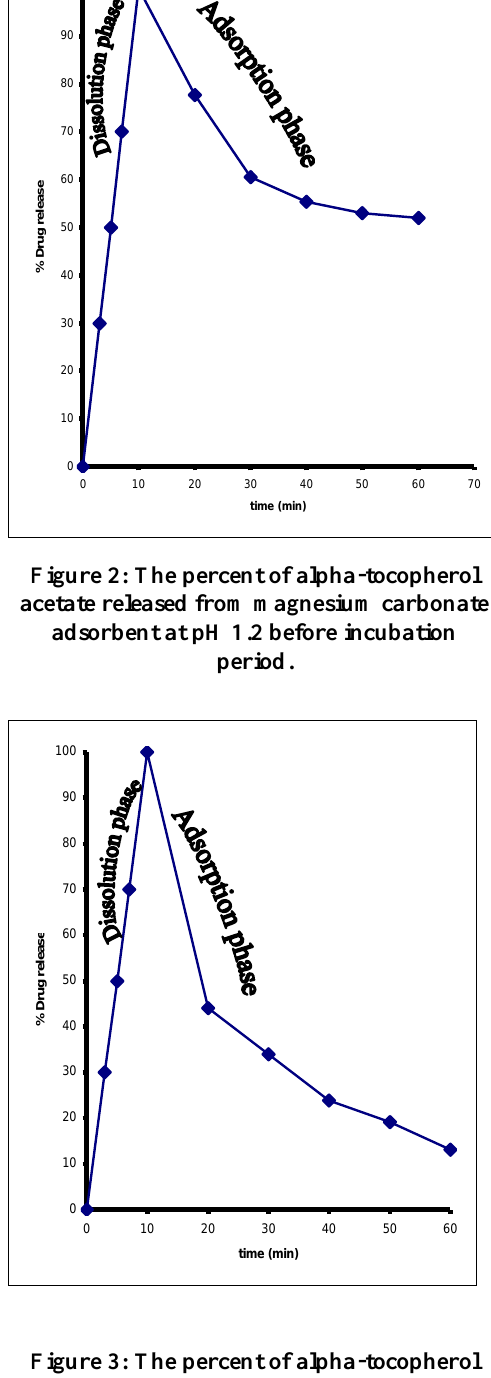
Figure 3: The percent of alpha-tocopherol acetate released from microcrystalline cellulose adsorbent at pH 1.2 before incubation